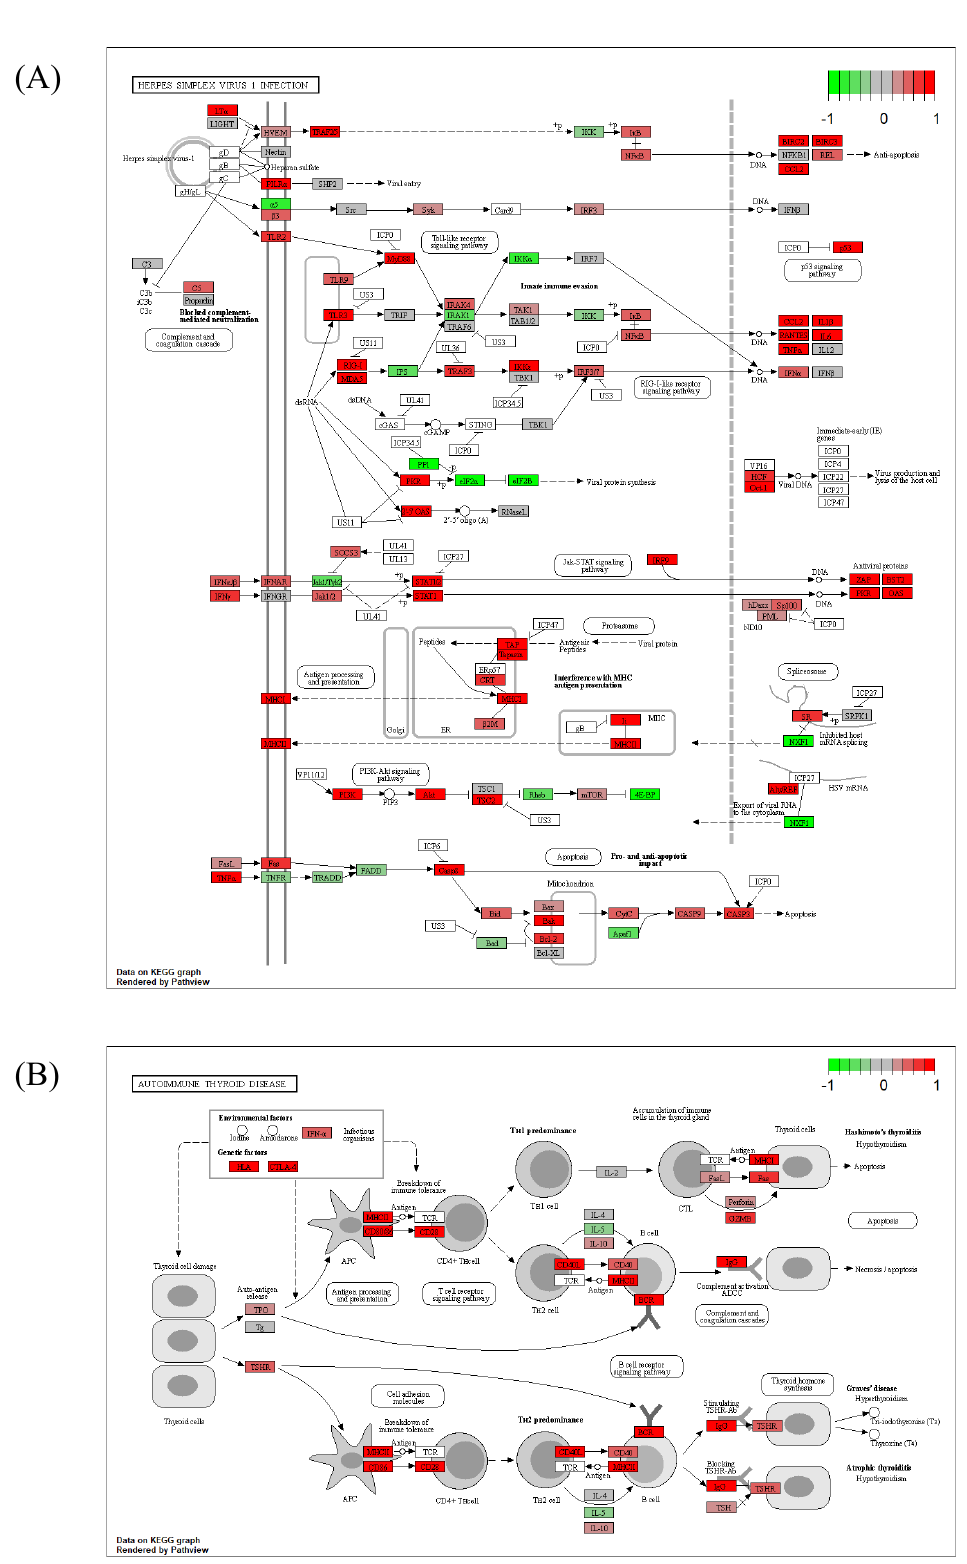
Figure 6. KEGG pathway mapping of ( A ) herpes simplex virus 1 infection pathway and ( B ) autoim- mune thyroid disease based on microarray data of the HT group. The plot was created by using PathView R package. The red-to-green color indicates the relative gene